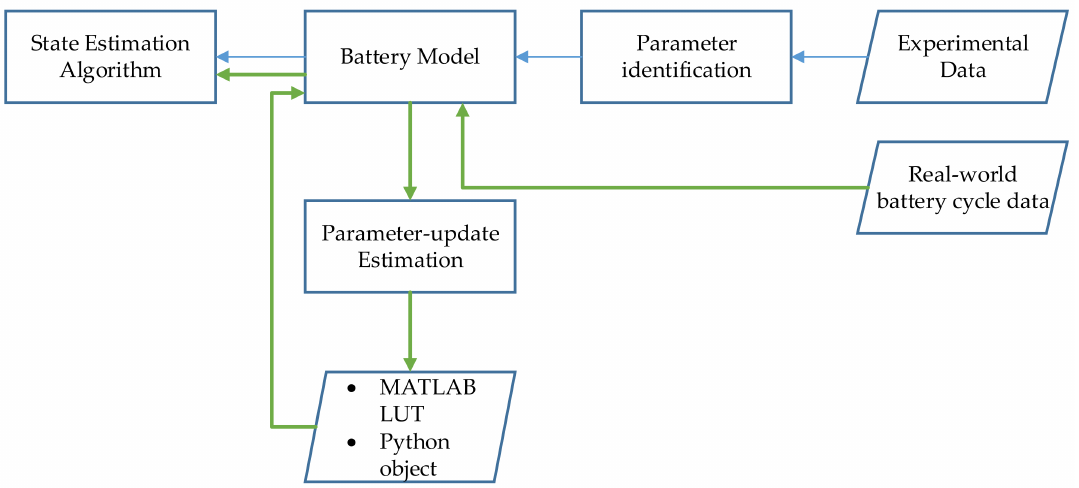
Figure 3. Software segment for implementation